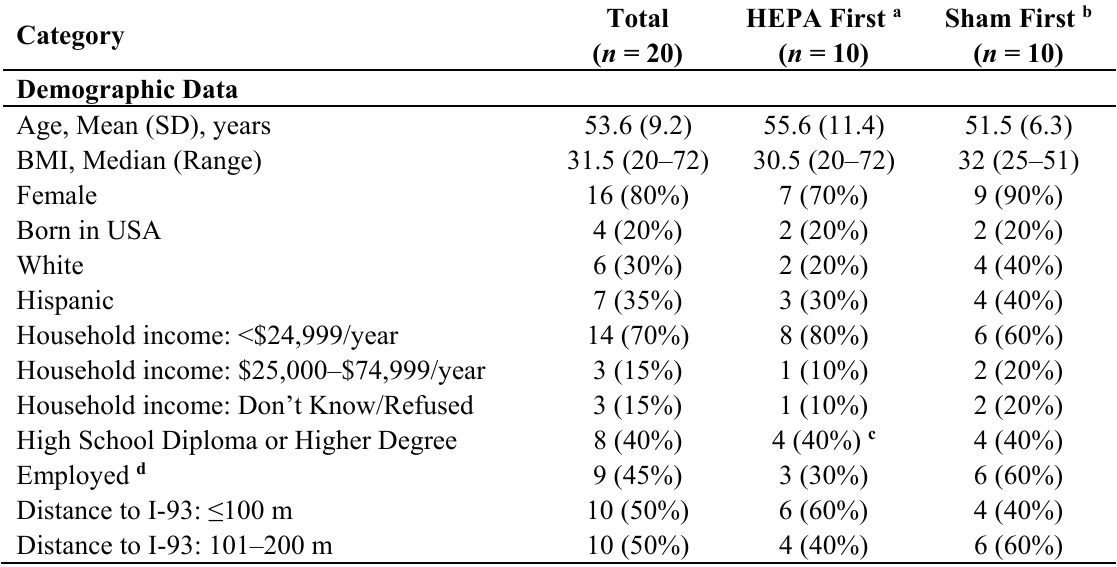
Table 1. Demographic and health data of the total study population and stratified by intervention